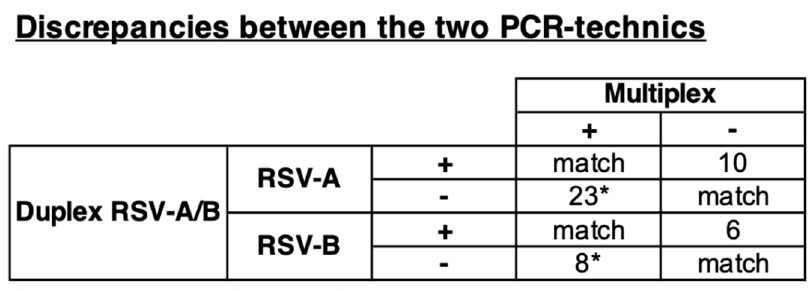
Figure 3. Discrepancies between the two PCR-technics. We compared the proportion of co-detections of HRV/RSV with the proportion of mono-detections of HRV: the risk of being infected by HRV is significantly higher in the absence of RSV detection ( p < 0.001, odds ratio = 0.09, IC 95% 0.0537; 0.1457). The risk of being co-infected by a coronavirus and HRV or RSV is not significantly different than not being co-infected by these viruses.